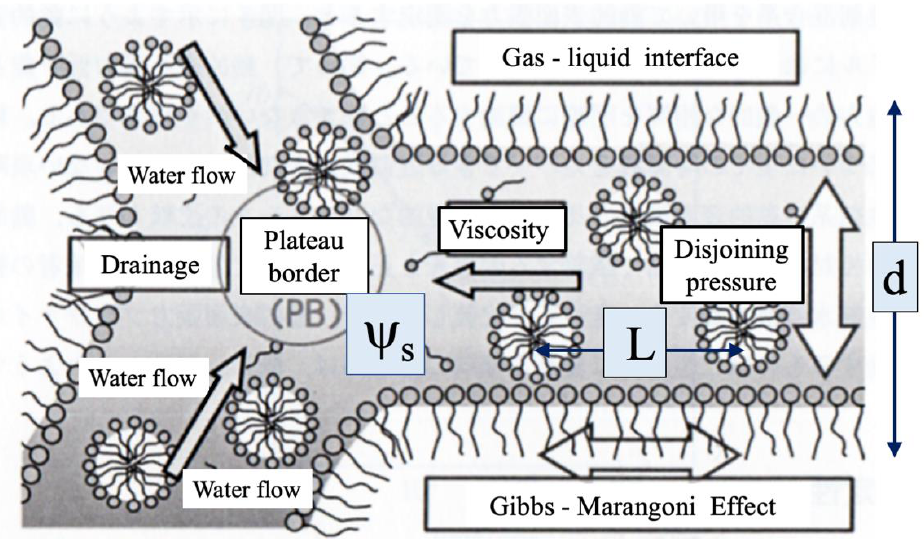
Figure 1. Schematic view of shampoo foam drawn by considering the picture by Dr. Sakai (Kao Corporation, Wakayama, Japan) [13]. Surfactants are allocated at the air surface; a hydrophobic tail faces to the air side, whereas a hydrophilic group is attached on the water side. Disjoining pressure maintains the film thickness ( d ). A triplet junction (plateau boarder) connects individual foam films. Laplace pressure causes water flow to the junction. Gravity causes foliation and collapse of the foam and drainage of water. The Gipps–Marangoni effect resists film breakage. Interestingly, micelles with spaces between them ( L ) are depicted in the foam film.